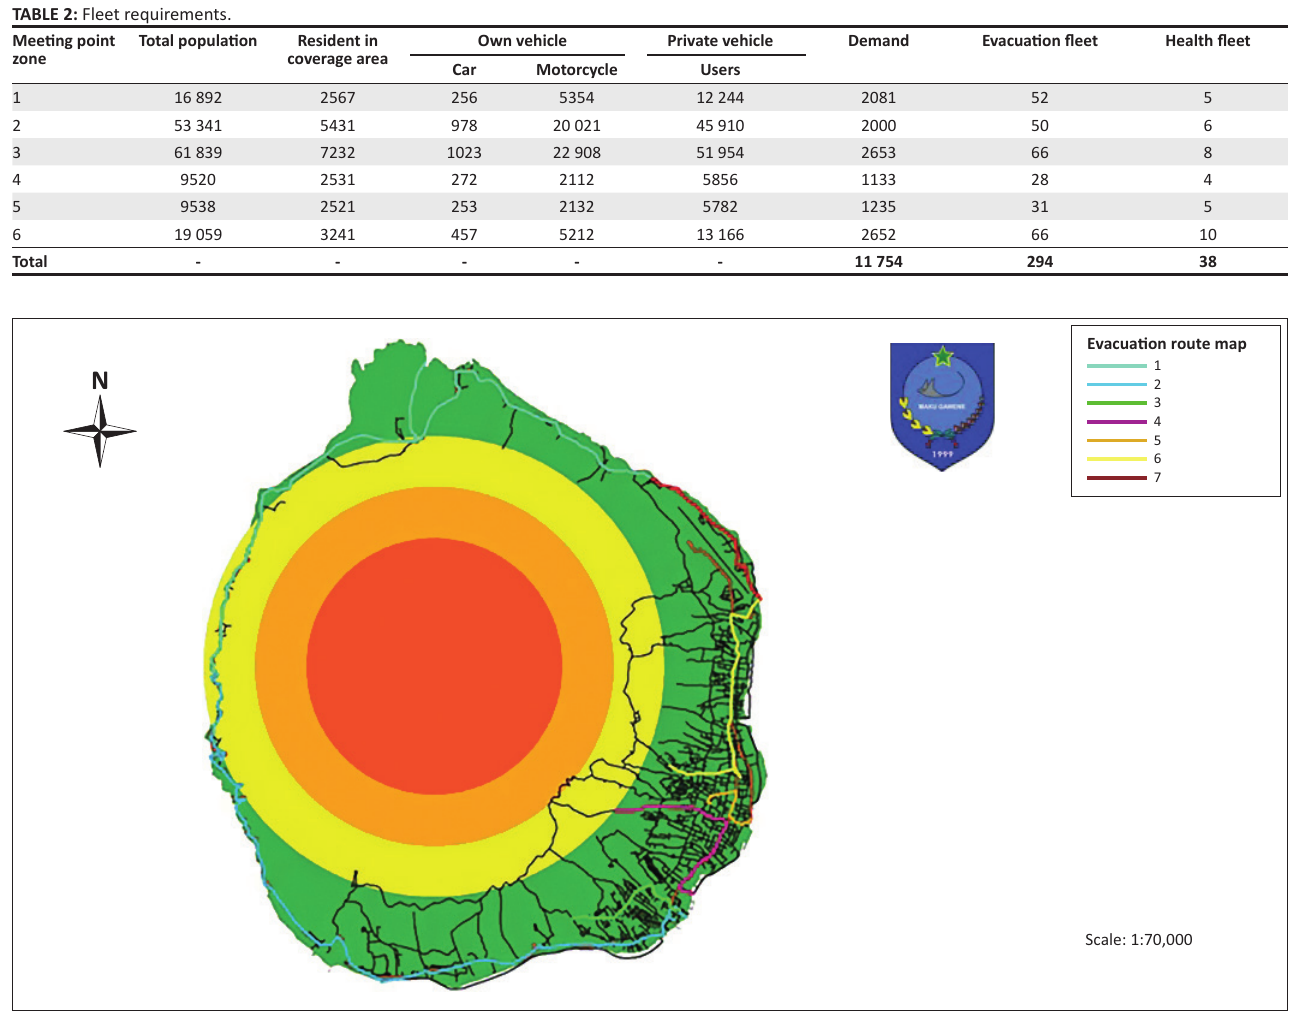
FIGURE 7 : Evacuation route map.